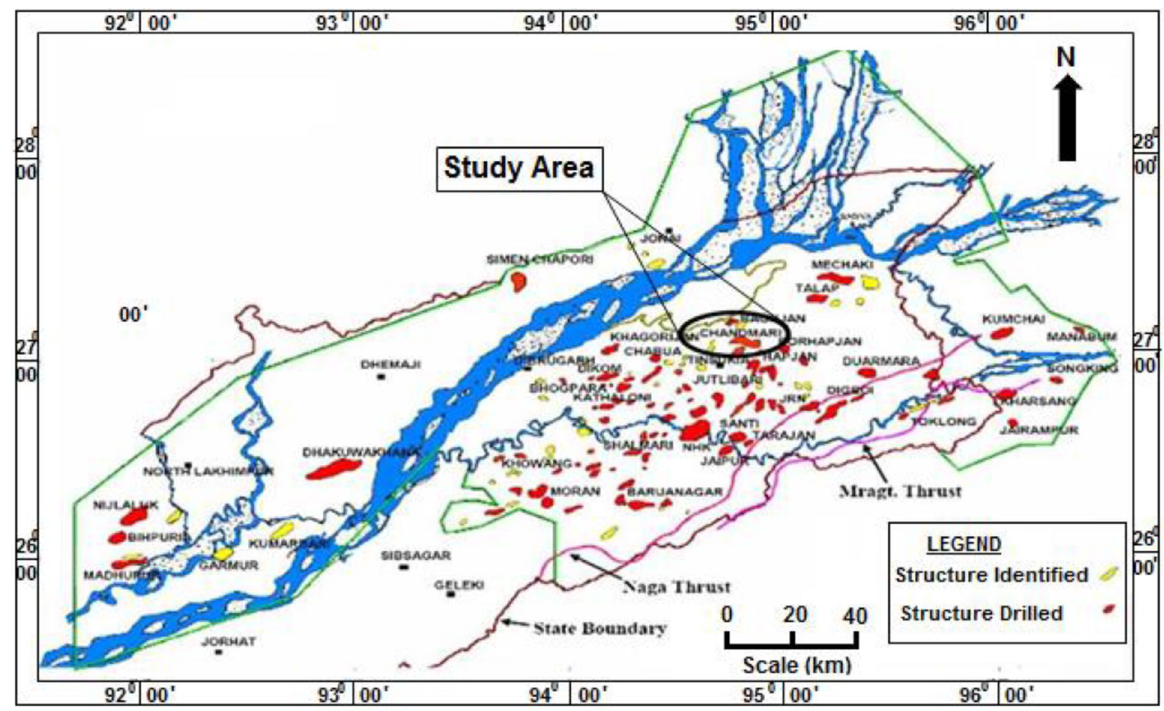
Fig. 1 Geological map of upper Assam-Arakan; study area is marked by black circle near Chandmari region. (After Mandal and Dasgupta